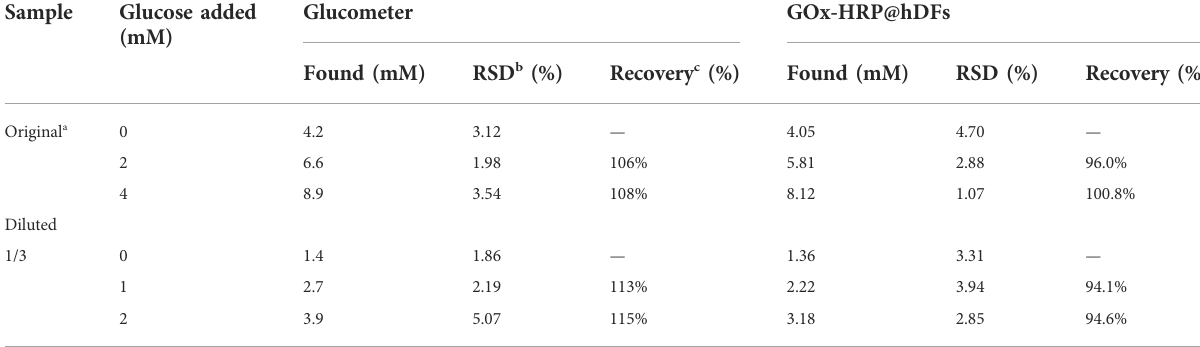
TABLE 3 Real sample analysis of the blood glucose levels in human serum based on a GOx-HRP@hDFs nanosystem. Sample